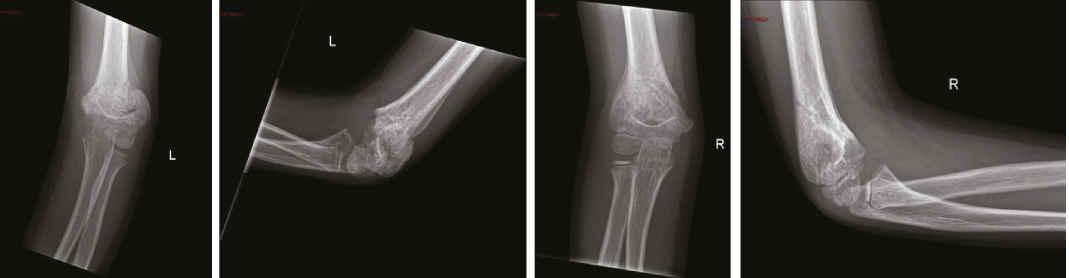
Figure 3: 4 weeks post-op X-rays. AP and lateral views of the right and left